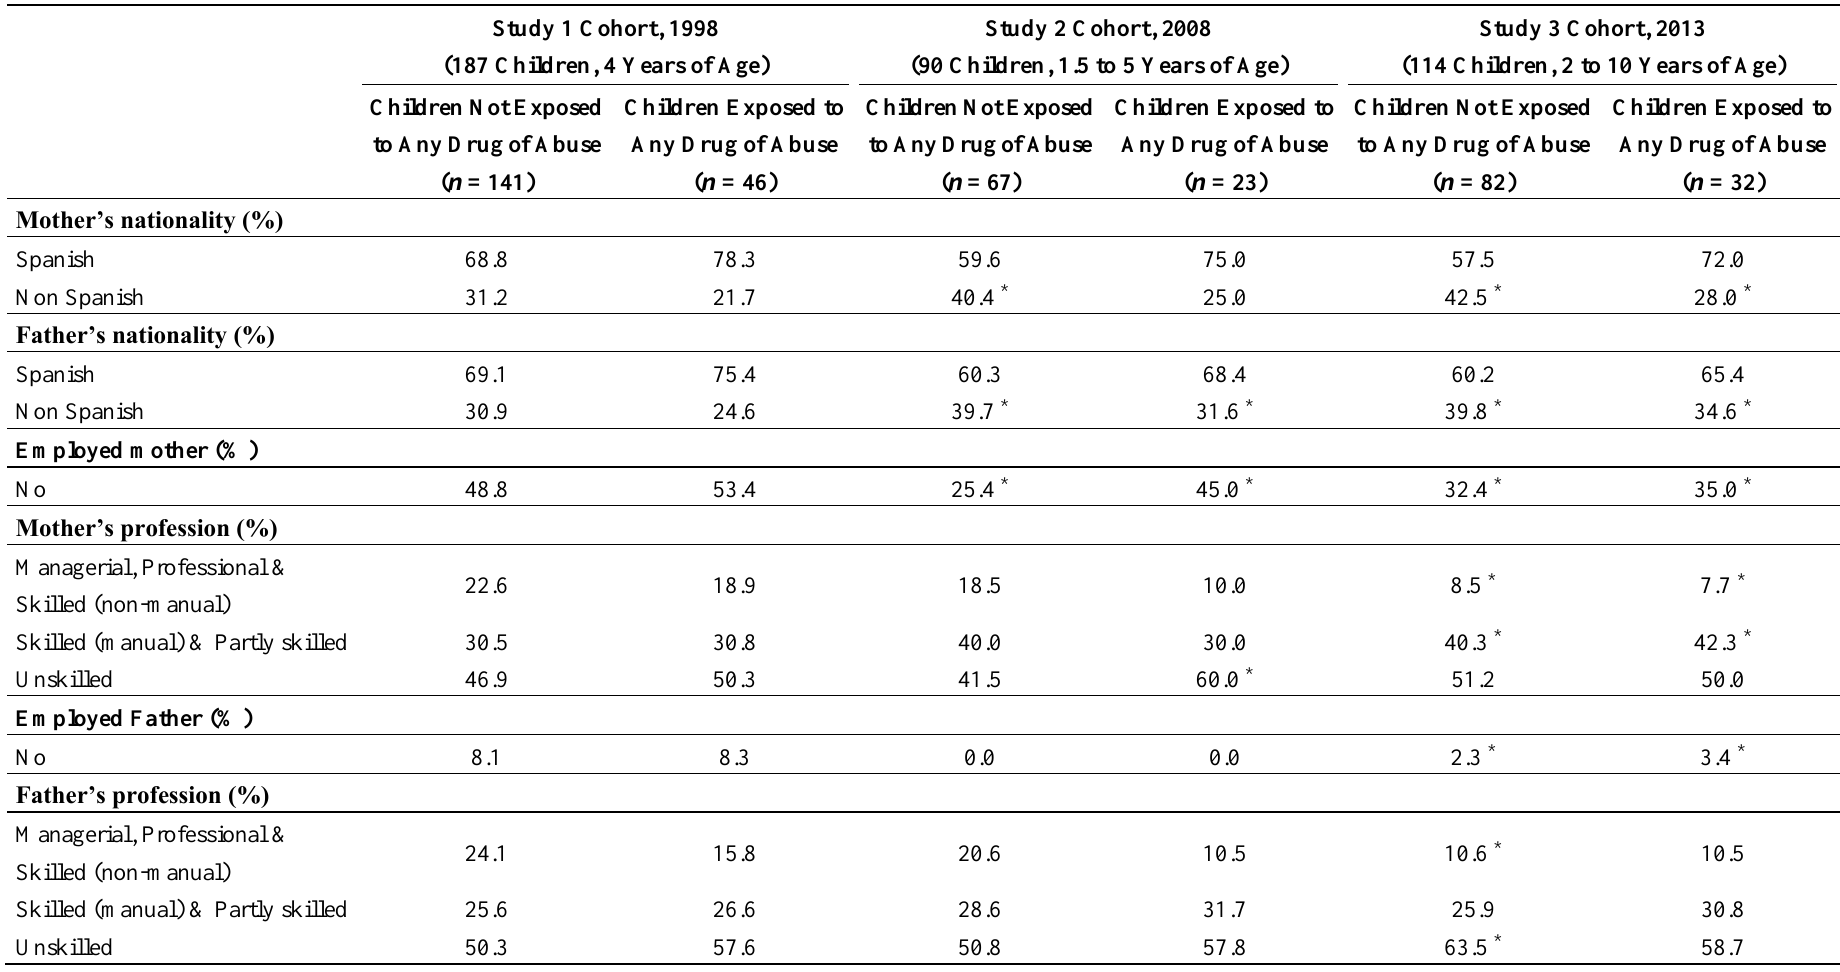
Table 2. Parental sociodemographics and exposure to drugs of abuse for each cohort children according to hair analysis. Study 1 Cohort, 1998 Study 2 Cohort, 2008 Study 3 Cohort, 2013 (187 Children, 4 Years of Age) (90 Children, 1.5 to 5 Years of Age) (114 Children, 2 to 10 Years of Age) Children Not Exposed Children Exposed to Children Not Exposed Children Exposed to Children Not Exposed Children Exposed to Any Drug of Abuse Any Drug of Abuse to Any Drug of Abuse Any Drug of Abuse